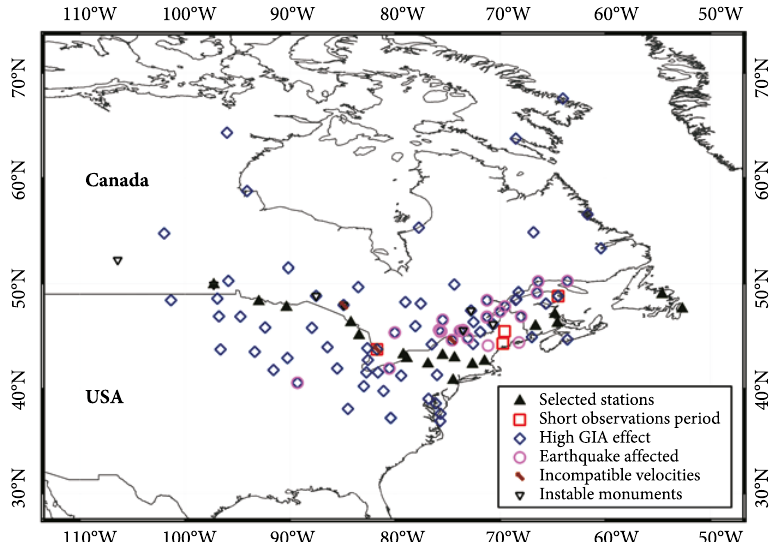
Fig. 2. Spatial distribution of the CGPS stations used in this study. Green solid triangles show the final selection. Other stations are excluded from the estimation process because they are affected by different phenomena explained in the text and therefore do not present the real tectonic rotation of the study